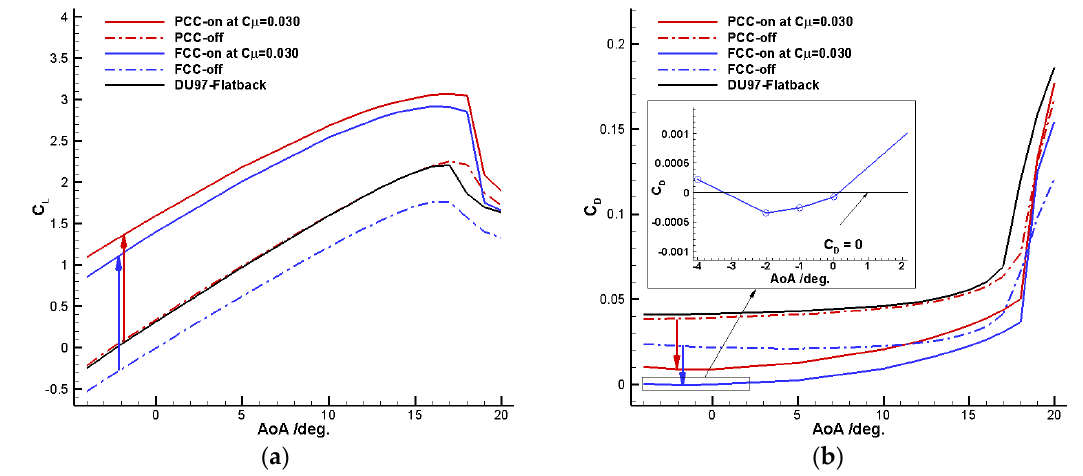
Figure 9. Comparison of lift and drag coefficients between different airfoils: ( a ) Lift coefficient; ( b ) Drag coefficient.